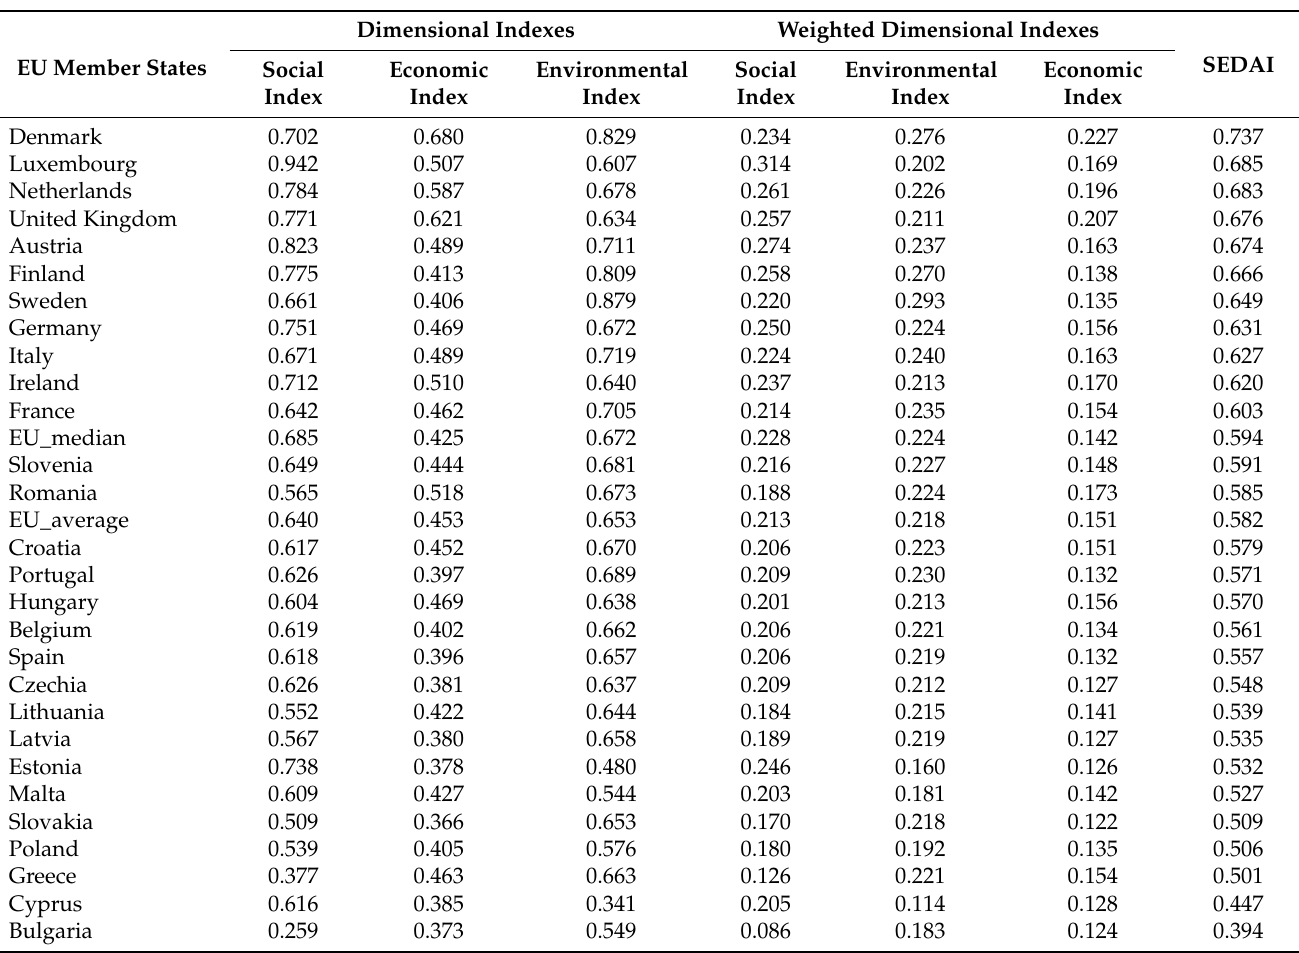
Table 6. Social, economic and environmental dimension indexes, weighted indexes and SEDAI in 2017 for the EU-28 Member